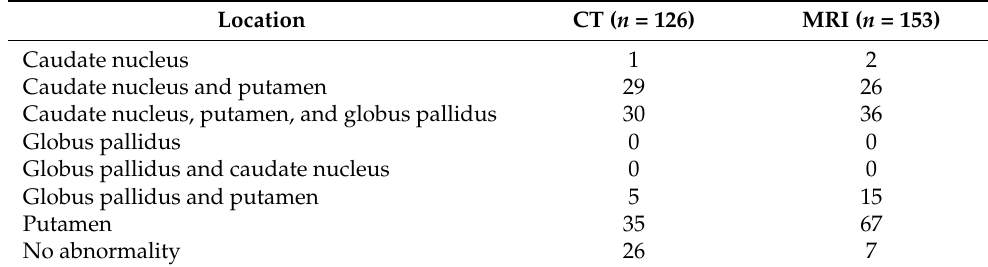
Table 1. Summary of the number of patients ( n ) with locations of striatal abnormalities from brain computed tomography (CT) and magnetic resonance imaging (MRI) (adapted from